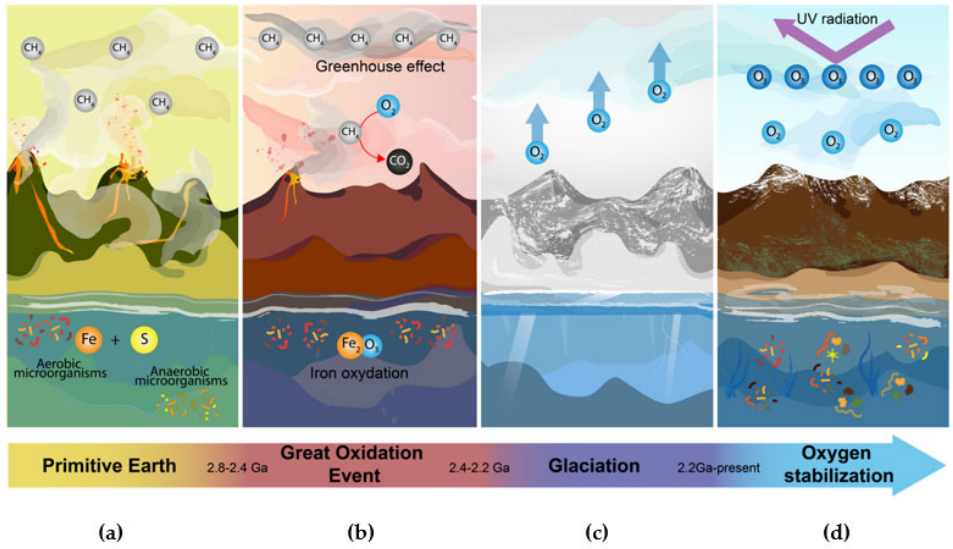
Figure 6. Transitions of the great oxidation event. ( a ) Primitive Earth. On early Earth, oxygen concentrations were very low. The atmosphere contained a large proportion of methane, while the oceans and their deep trenches had high availability of elements such as iron and sulfur [74–76]. ( b ) Great Oxidation Event. Cyanobacteria began to produce oxygen as a byproduct of photosynthesis. Oxygen bioprocessing created reactive species that were highly toxic to organisms and, in turn, began to interact with oceanic iron and atmospheric methane. This caused the generation of iron oxide, turning the seas red, and a gradual increase of oxygen and carbon dioxide in the atmosphere [72,74,77]. ( c ) Glaciation. The removal of methane from the atmosphere caused the existing greenhouse effect to be lost. This caused a dramatic drop in temperature freezing the entire planet, killing a wide variety of species [72,77]. ( d ) Oxygen Stabilization. The continuous production of oxygen caused ozone to accumulate in the atmosphere and form a layer that retains UV radiation. This favored the emergence of organisms capable of taking advantage of the available oxygen, which regulated the levels of reactive species in the atmosphere [75,78].